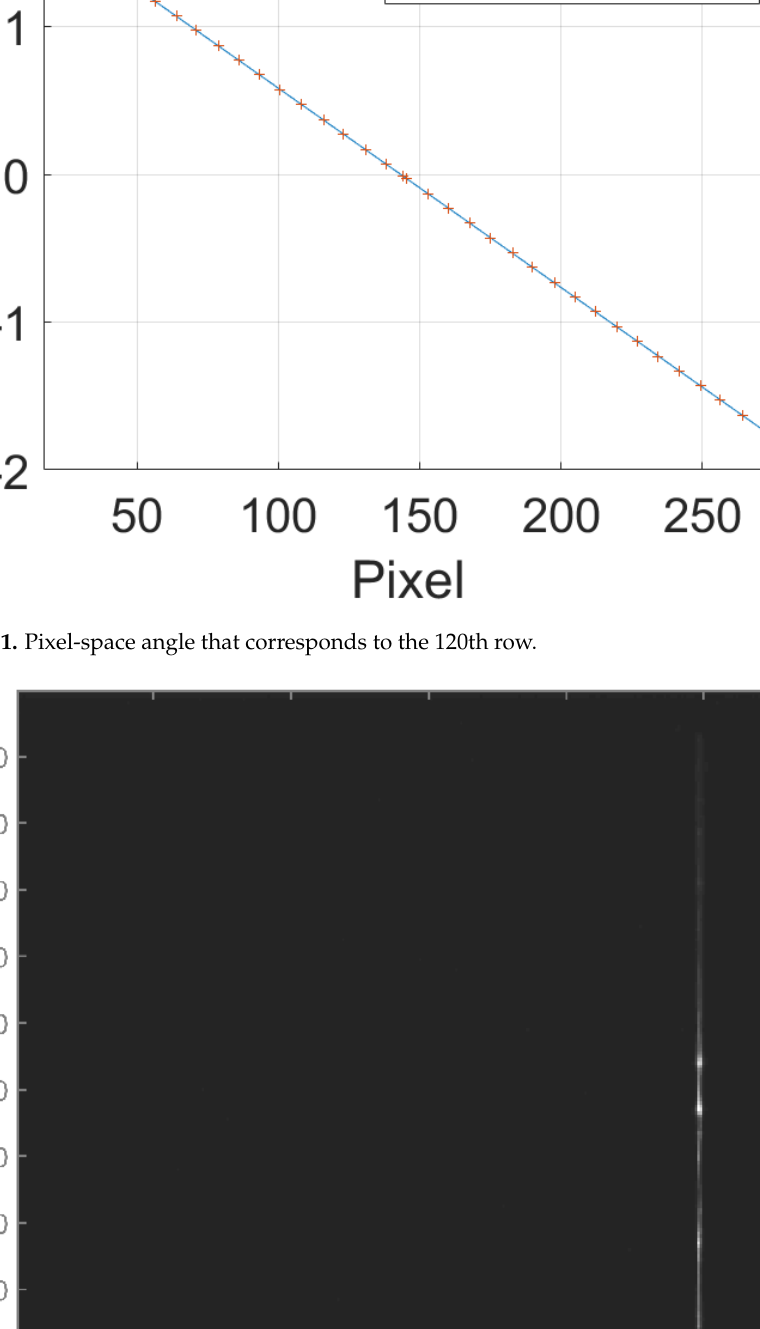
Figure 11. Pixel - space angle that corresponds to the 120th row.